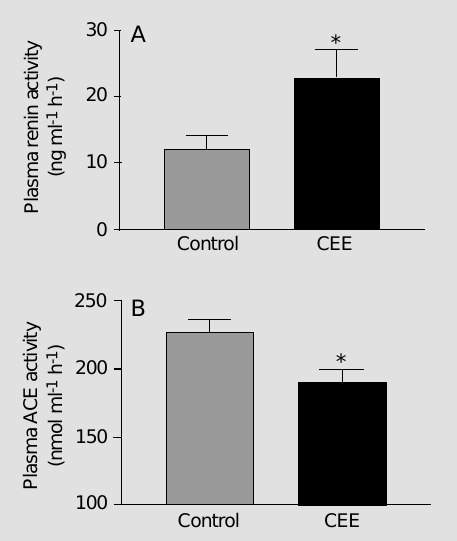
Figure 1 - Effects of estrogen on plasma renin activity (A) and an- giotensin converting enzyme ac- tivity (B). Values are reported as mean ± SEM. *P<0.05 vs con- trol (Student t -test). All cynomol- gus monkeys were ovariecto- mized and left either untreated (control, N = 14) or treated with conjugated equine estrogens (CEE; N = 15). (Reproduced from Ref. 72 with